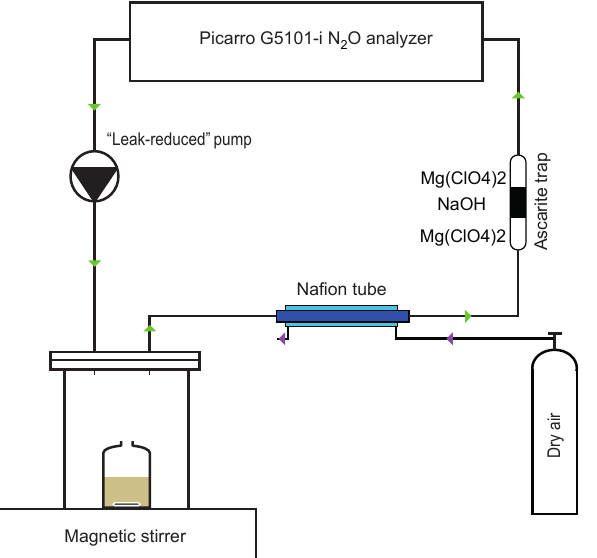
Figure 1. Simplified schematic of the incubation setup. The green and the purple arrows show the flow direction of the measuring gas and the purge gas, respectively.